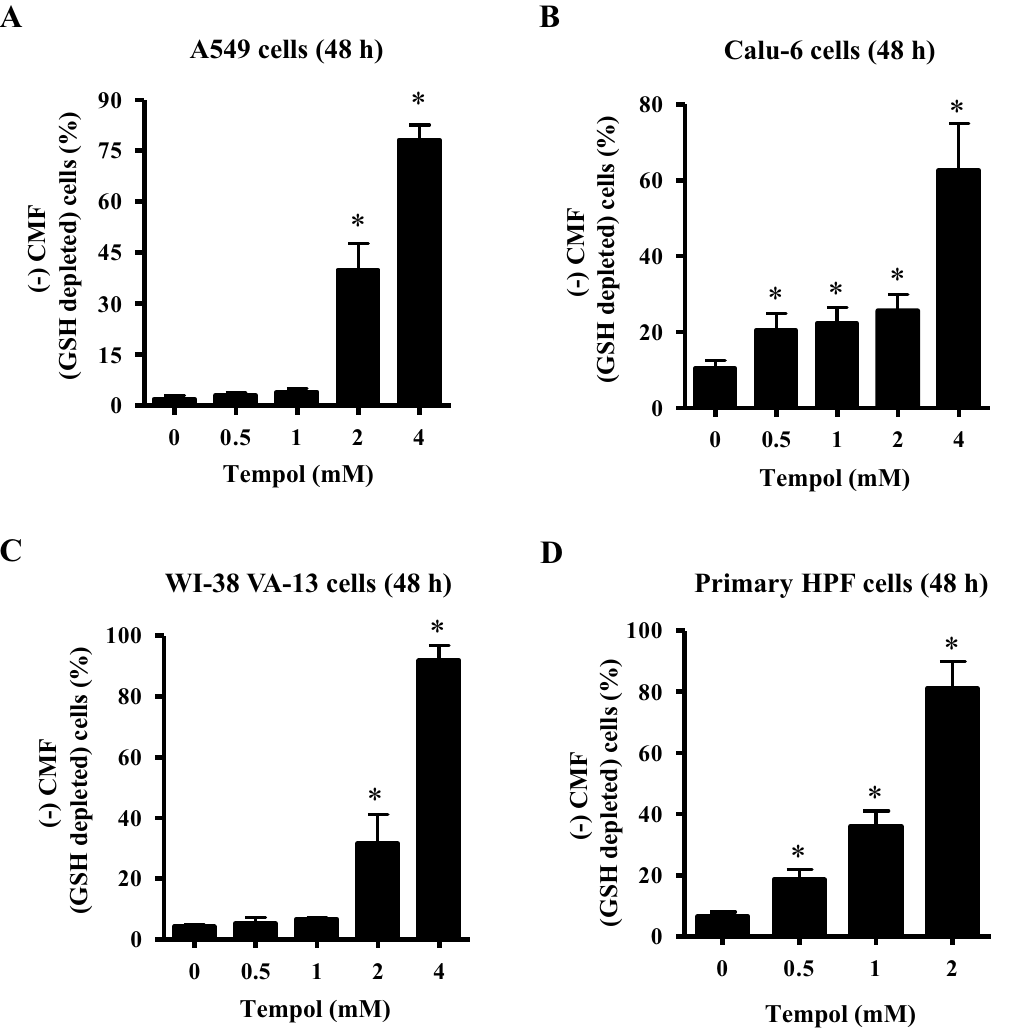
Figure 7. Effects of Tempol on intracellular GSH depletion in lung cancer and normal cells. Cells in the exponential growth phase were incubated with the indicated concentrations of Tempol for 48 h. Intracellular CMF (GSH) levels in various lung cells were measured using a FAC Star flow cytometer. The graphs indicate the percentages of (–) CMF (GSH-depleted) in A549 cells ( A ), Calu-6 cells ( B ), WI-38 VA-13 cells ( C ), and primary HPF cells ( D ). *p < 0.05 compared with untreated